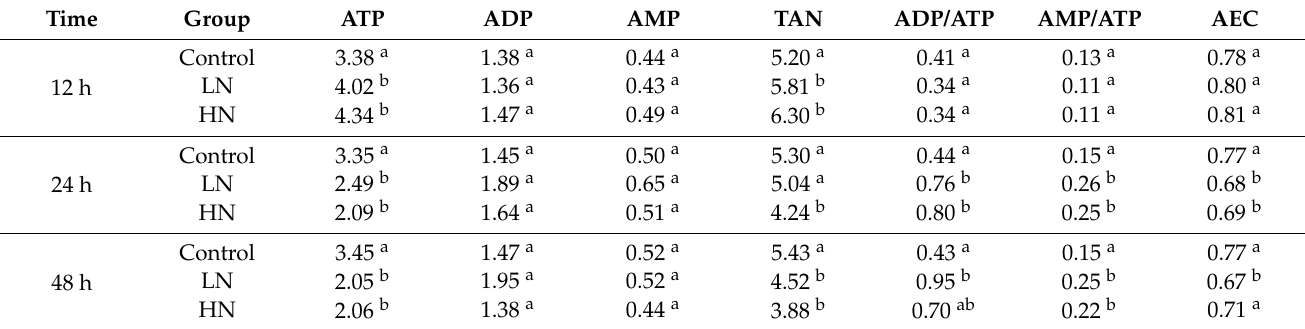
Values are means (n = 3). Values with different letters in the same column at each time point are significantly different ( p < 0.05).